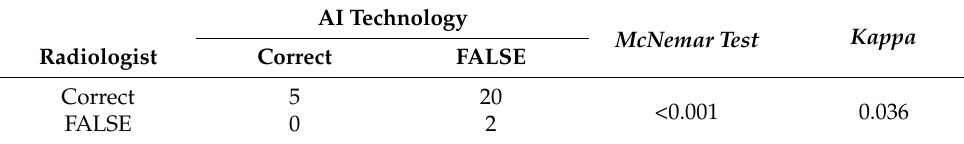
Table 3. The prediction results of benign SPNs.